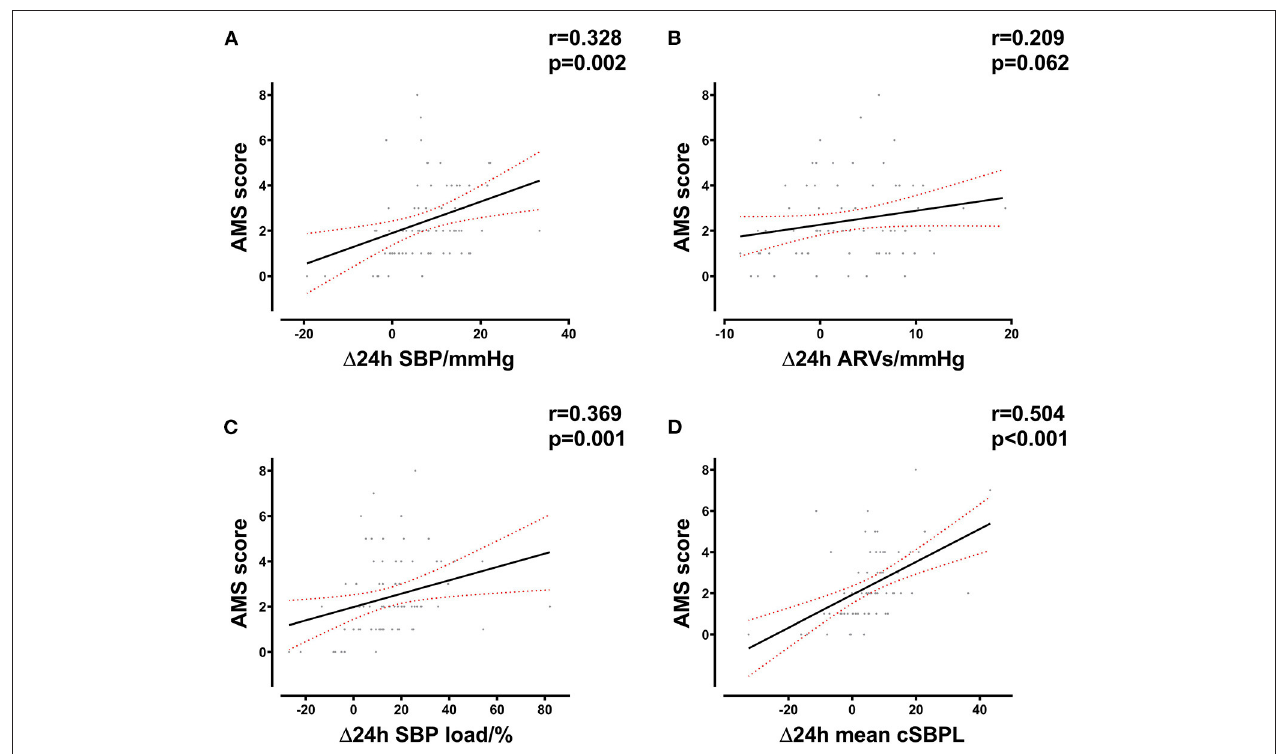
FIGURE 4 | Correlation between delta 24-h SBP parameters and AMS score. (A) Correlation between delta 24-h SBP after HA exposure and AMS score in all subjects. (B) Correlation between delta 24-h ARVs after HA exposure and AMS score in all subjects. (C) Correlation between delta 24-h SBP load after HA exposure and AMS score in all subjects. (D) Correlation between delta mean 24-h cSBPL after HA exposure and AMS score in all subjects. HA, high altitude; AMS, acute mountain sickness; SBP, systolic blood pressure; cSBPL, cumulative systolic blood pressure load; ARVs, average real variability of